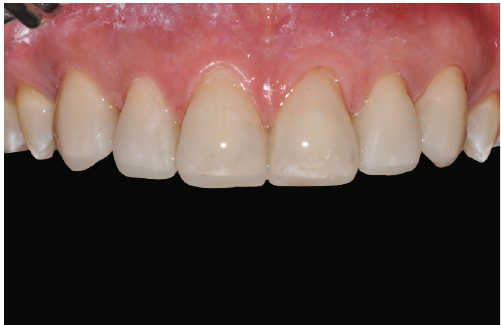
Figure 8: Mock-up printing on fi nal preparations.